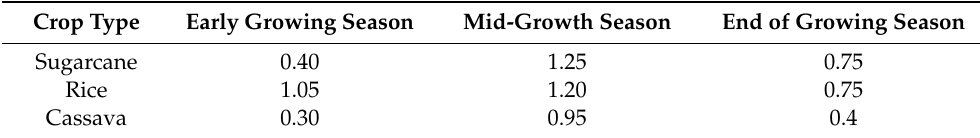
Table 1. Growth season crop coefficients.